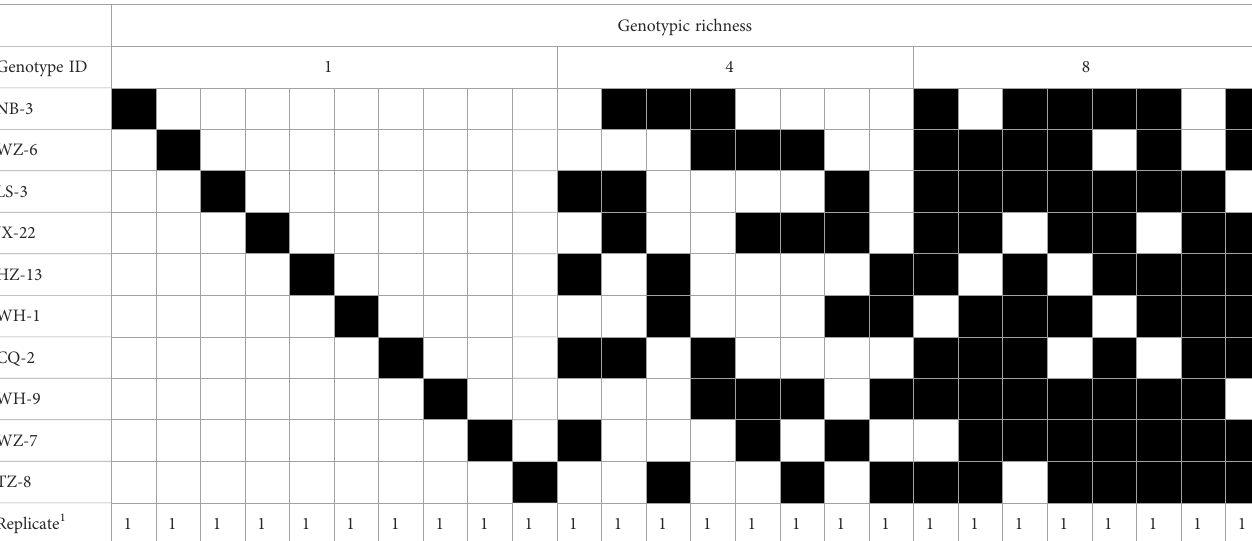
TABLE 2 Genotype combination used for different genotypic richness